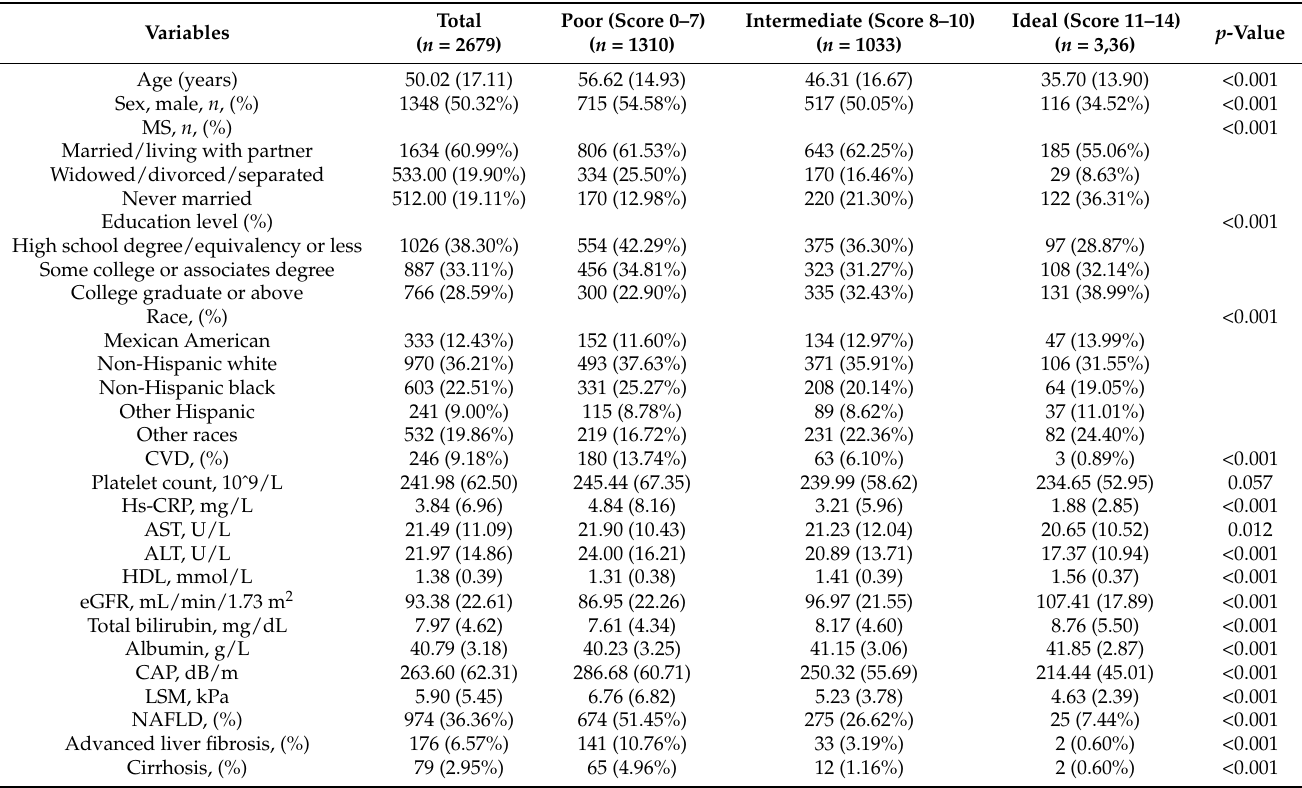
Table 1. Baseline characteristic according to the CVH metrics